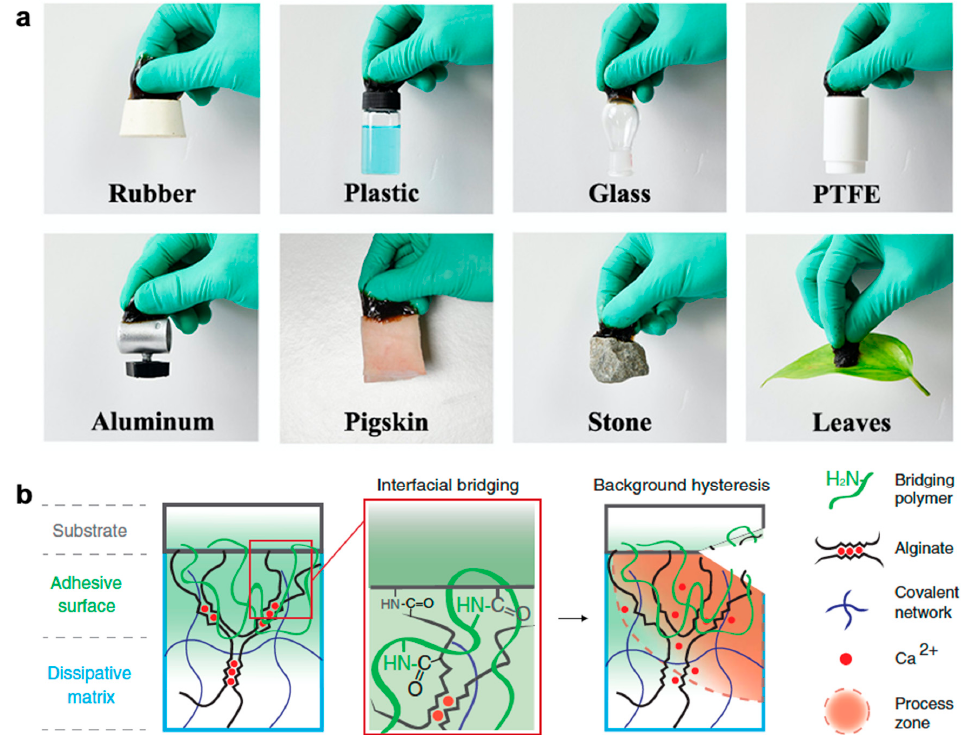
Figure 8. ( a ) Demonstration of PDA-based hydrogel adhesion to various materials. Adapted with permission from [210]. Copyright 2019, American Chemical Society. ( b ) Design schematic for a